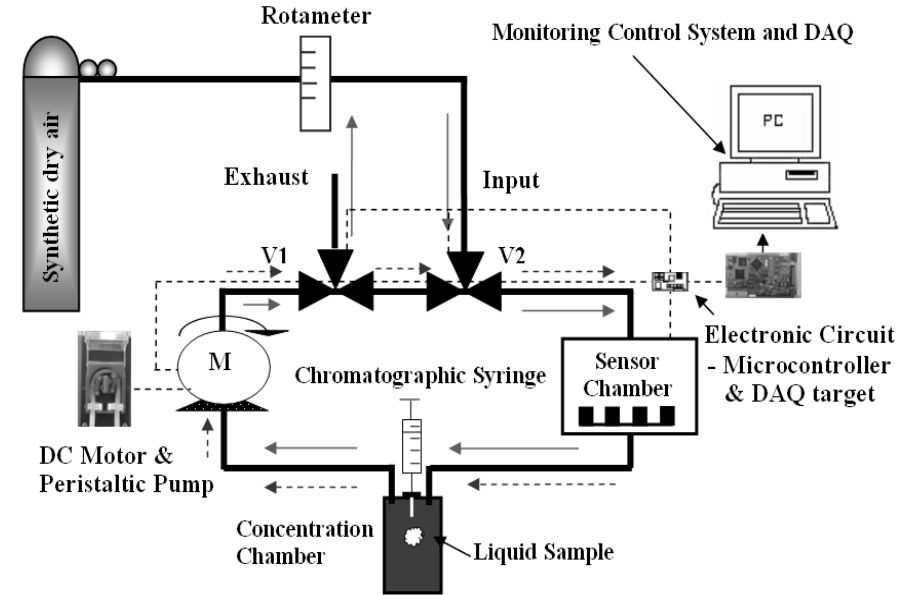
Figure 1. Experimental set-up during flow modulation